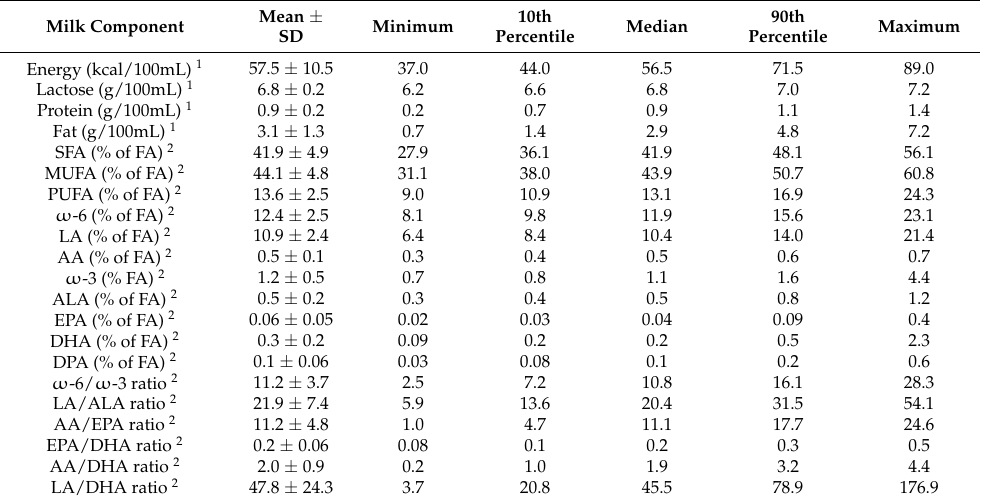
Table 1. Distribution of human milk components among 300 breastfeeding mothers. Italy,